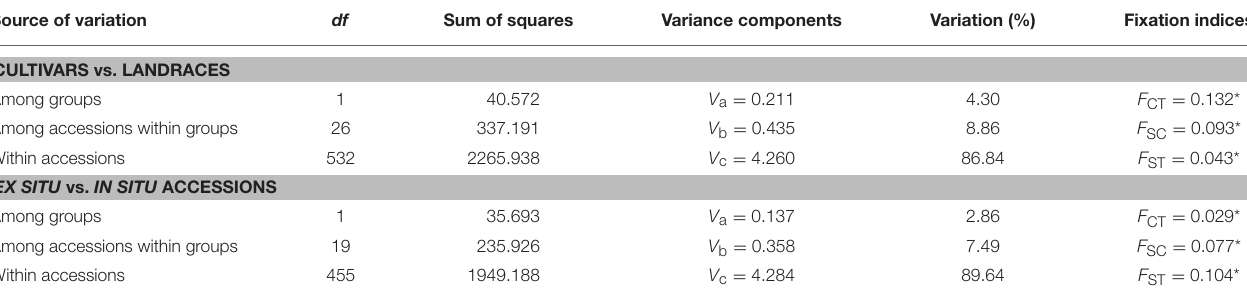
TABLE 4 | AMOVA results including fixation indices F CT , F SC , and F ST .